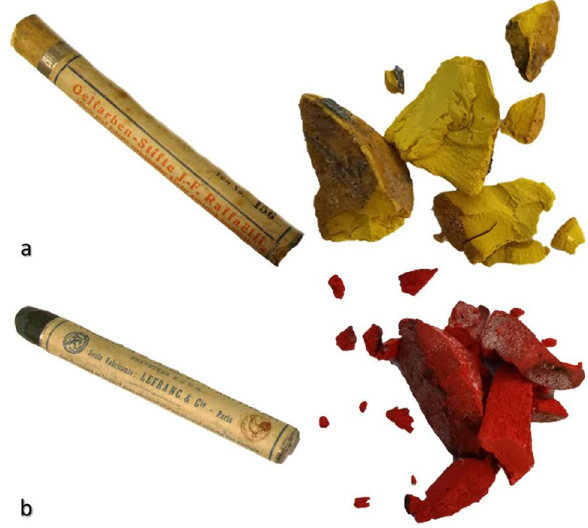
Figure 1. Two examples of pastels crayons and the micro-fragments collected for the analytical study: (a) yellow color from Oljefarben-Stifte J. F. Raffaelli of Dr. Fr. Schoenfeld; (b) red colour from Couleurs a l’huile J.F. Raffaelli of